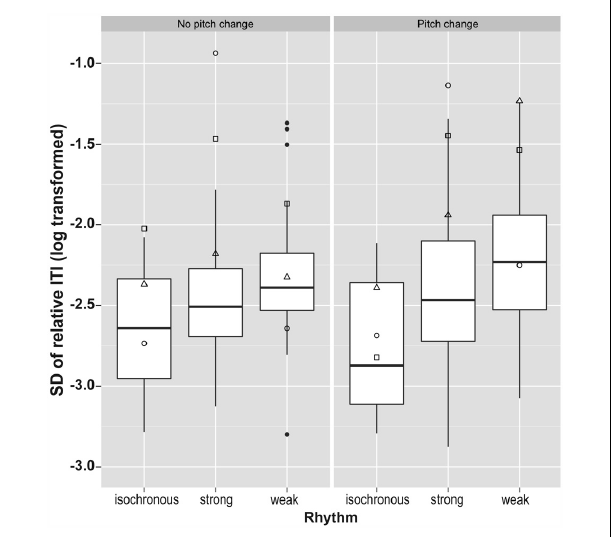
FIGURE 5 |Variability in tapping rate in all six conditions for the synchronization task. (cid:3) = SS; ◦ = SWI; (cid:4) = VPO. Filled circles represent outlying control